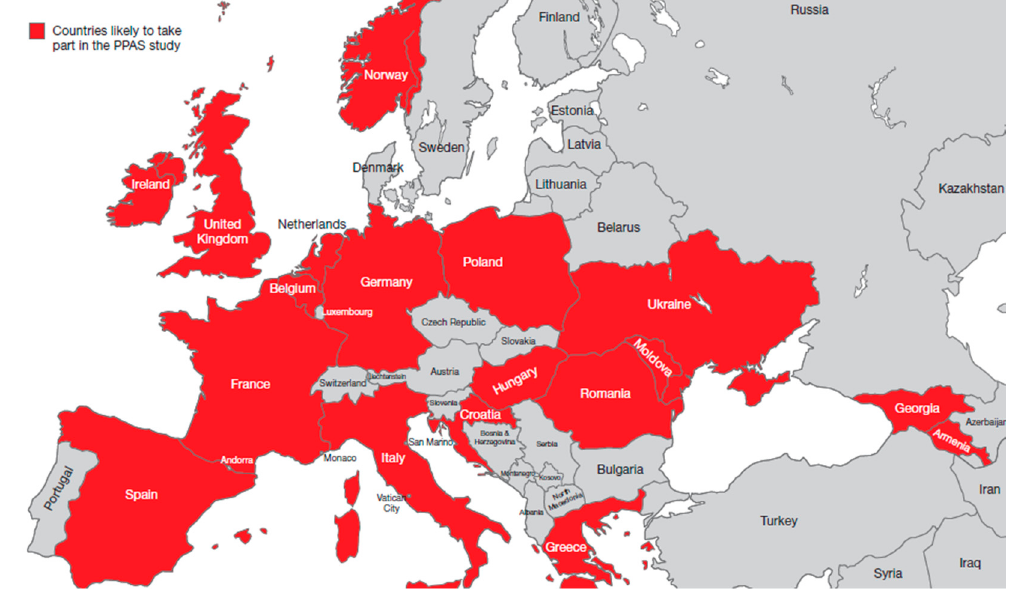
Figure 3. European countries expected to take part in the VALUE-Dx Point Prevalence Audit Survey (PPAS) study.